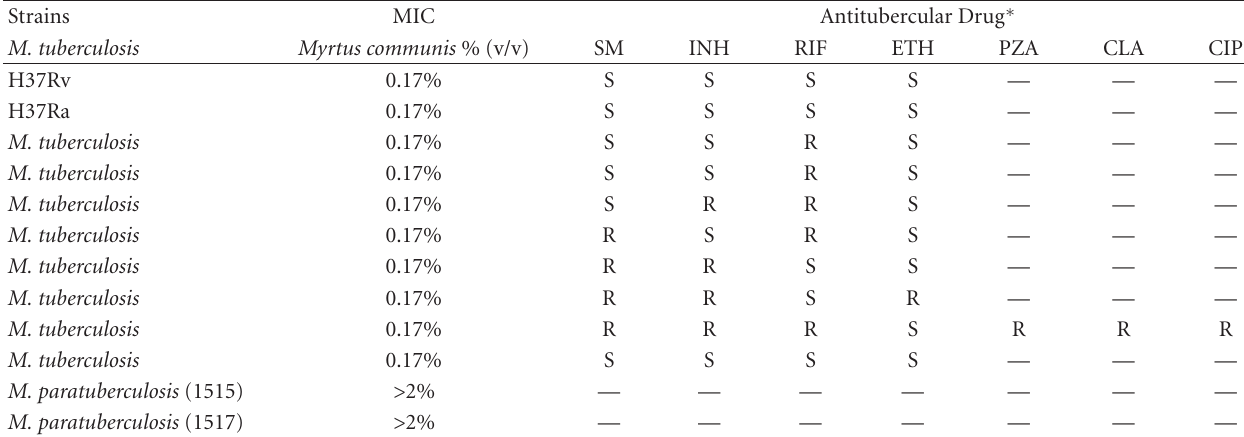
Table 1: Activity of antitubercular drugs and Myrtus communis against Mycobacterium tuberculosis strains. Strains